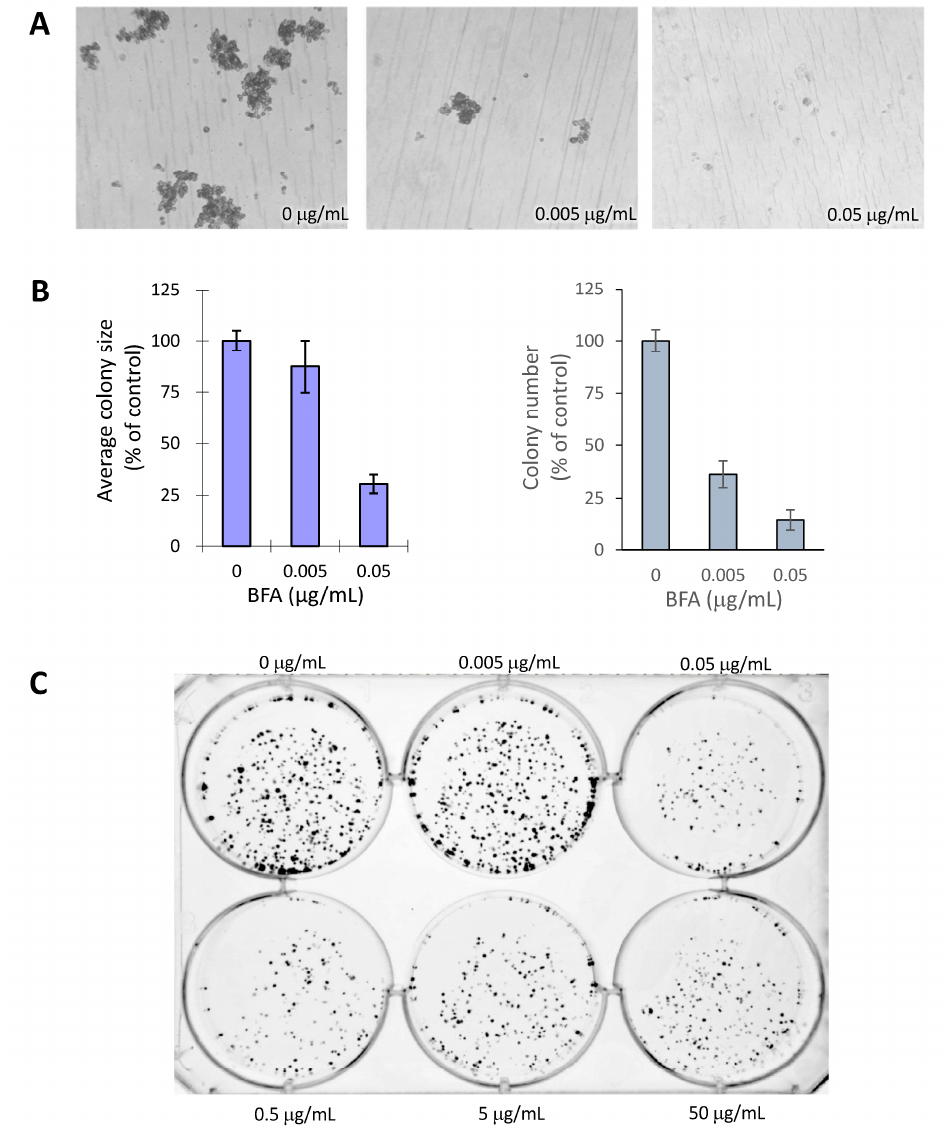
Figure 2. BFA inhibited the formation of 3D and 2D colonies in MDA-MB-231. ( A ) Representative micrographs showing the formation of tumorspheres by MDA-MB-231 cells treated with 0, 0.005 and 0.05 μ g/mL BFA for 7d using soft agar assay. ( B ) Quantitative analyses of results from (A) using ImageJ software show the reduction of the size and number of tumorspheres by BFA. ( C ) Colony formation by adherent MDA-MB-231 cells pretreated with 0–50 μ g/mL BFA for 24 h. Colonies were generated from 1000 viable cells per well, allowed to grow for 12 d, and then fixed and stained by crystal